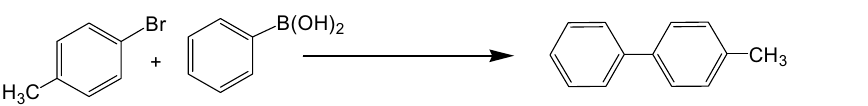
Table 2. The optimization study in the reaction of 4-bromotoluene with phenyl boronic acid over UiO-66- biguanidine/Pd a .